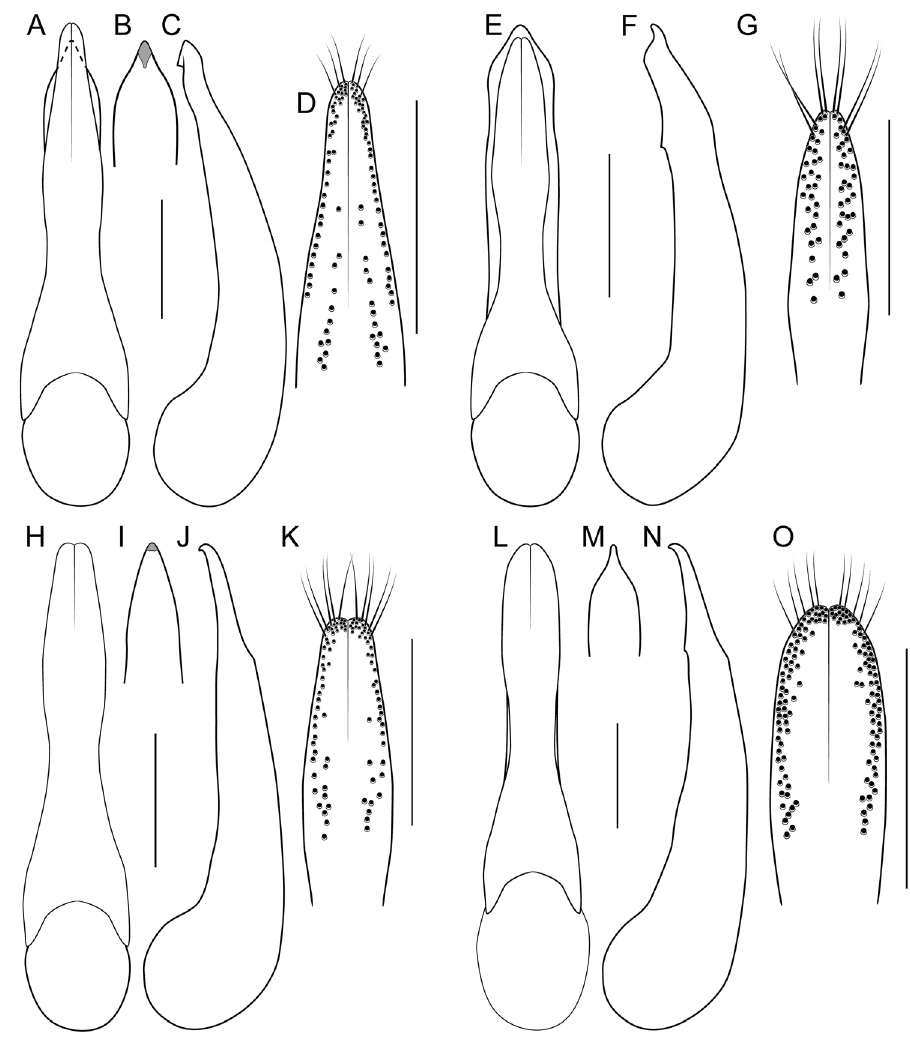
Figure 13. Bolitogyrus luteus Brunke ( A–D ), B. sepilok Brunke ( E–G ), B. vulneratus (Fauvel) ( H–K ) and B. flavus Yuan et al. ( L–O ). Aedeagus in parameral view ( A, E, H, L ), apex of median lobe in parameral view ( B, I, M ), median lobe in lateral view ( C, F, J, N ), peg setae of paramere ( D, G, K, O ). Scale bars: 0.5